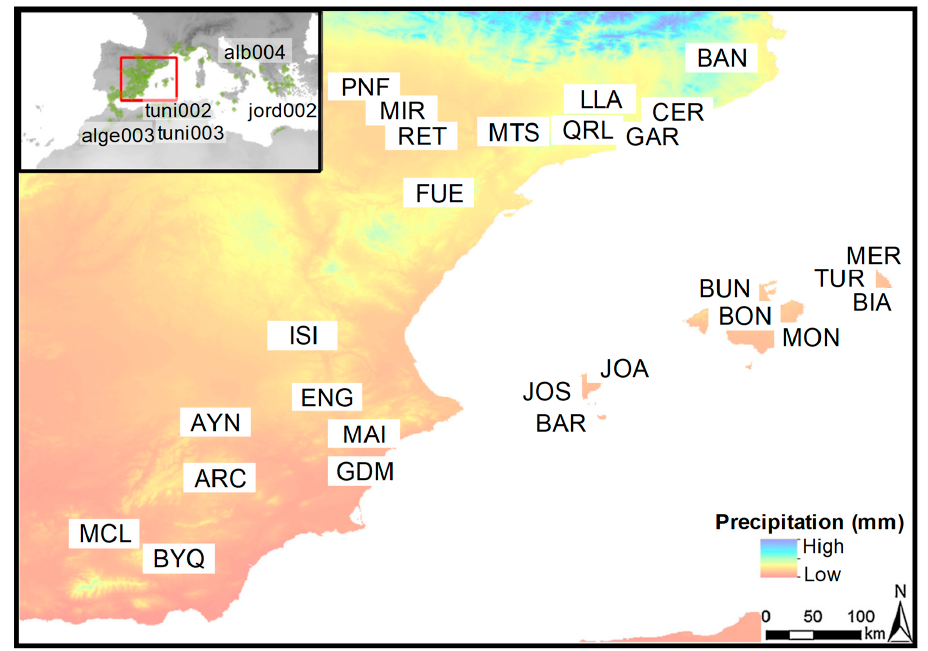
Figure 1. Map showing the location of the study sites (see sites’ codes in Table 1). The larger map shows the locations of the forests in eastern Spain. The upper inset map shows the distribution of Aleppo pine in the Mediterranean Basin (green), the eastern study region (red square) and the approximate location of International Tree-Ring Data Bank (ITRDB) sites. The background color key of the map shows the precipitation of the driest quarter (period of three months).